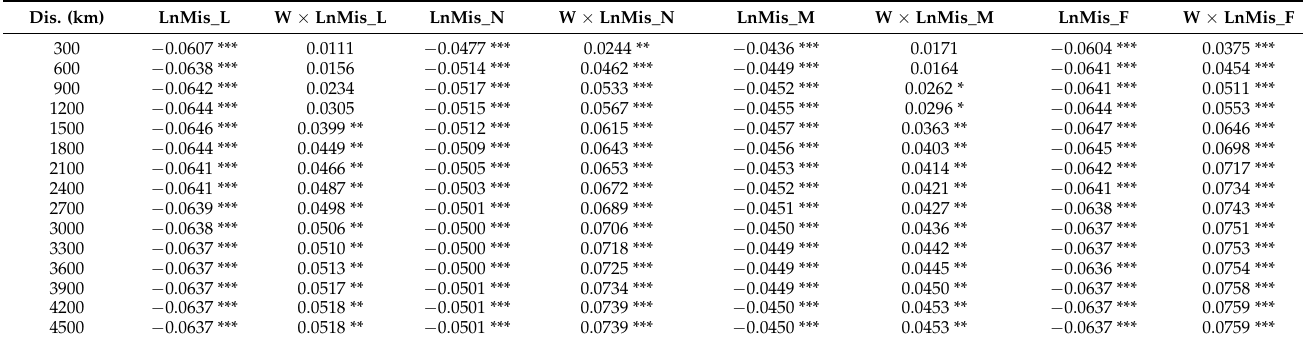
Table 13. Geographical distance dynamic test results.